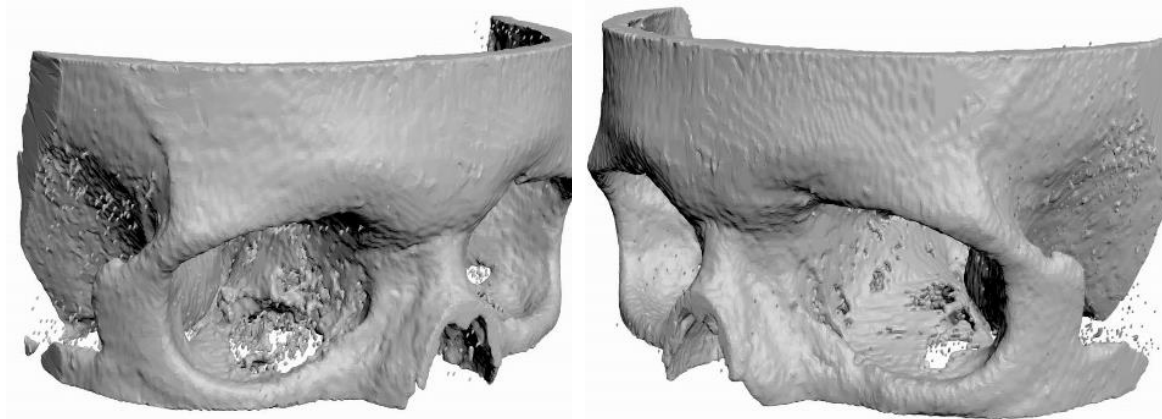
Figure 1. Type of three-dimensional model of bones of the facial skull: the result of the construction of a 3D